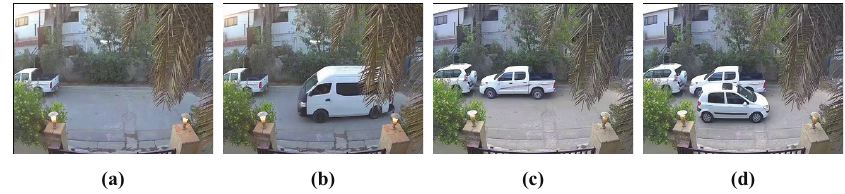
Fig. 1. Frame samples before and after the emergence of the target moving vehicle